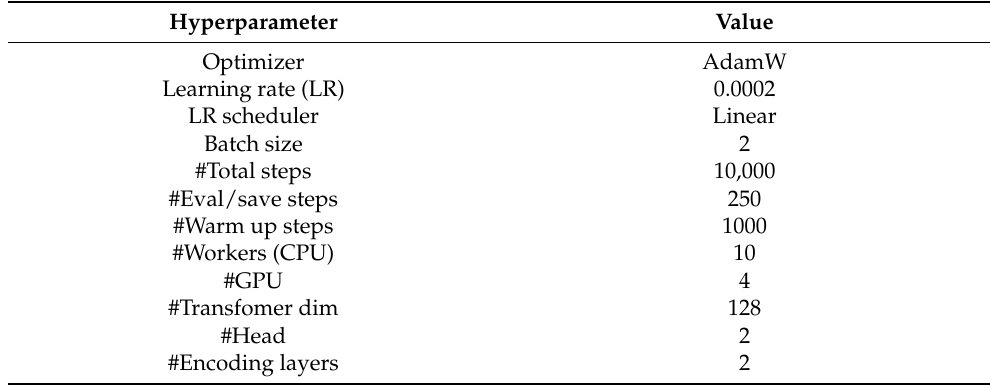
Table 2. Hyperparameters used in the